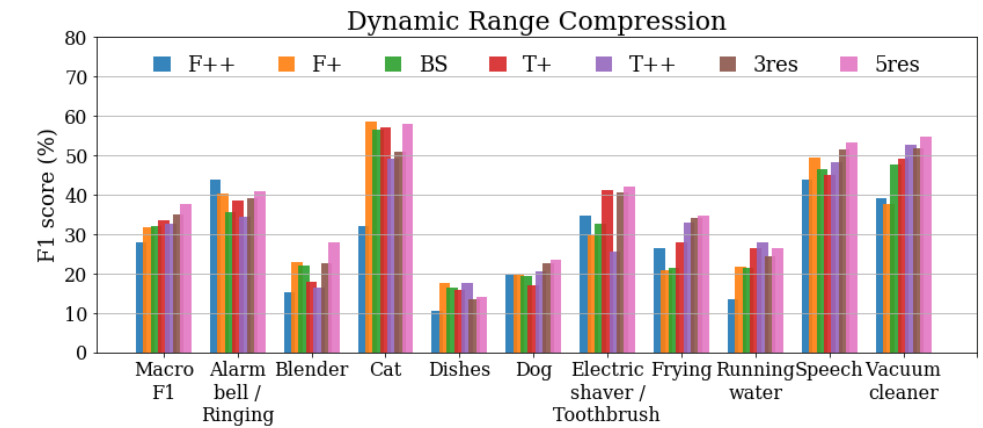
Figure 5. F 1 scores of single-resolution systems ( F ++ , F + , BS , T + , T ++ ) and the multiresolution systems ( 3res , 5res ) over DESED Public Evaluation set applying dynamic range compression. “Macro F1” shows average score over 10 target categories. Best viewed in color.